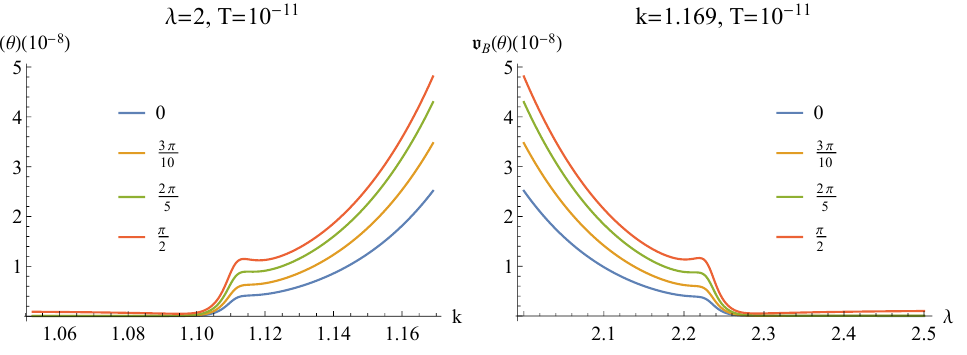
Figure 6 . Left plot: v B ( (cid:18) ) at (cid:21) = 2 ; T = 10 (cid:0) 11 . Right Plot: v B ( (cid:18) ) at k = 1 : 169 ; T = 10 (cid:0) 11 . Four curves in each plot corresponds to di(cid:11)erent angle (cid:18) speci(cid:12)ed by the plot legend. At last, we point out that the v ( (cid:18) ) can diagnose the QPT in any direction. As we can B v see from (cid:12)gure 7 that @ ( (cid:18) ) reaches local maximums near the QCP in any direction. This B k phenomenon re(cid:13)ects the fact that the di(cid:11)erent IR (cid:12)xed point leads to distinct behavior of v ( (cid:18) B